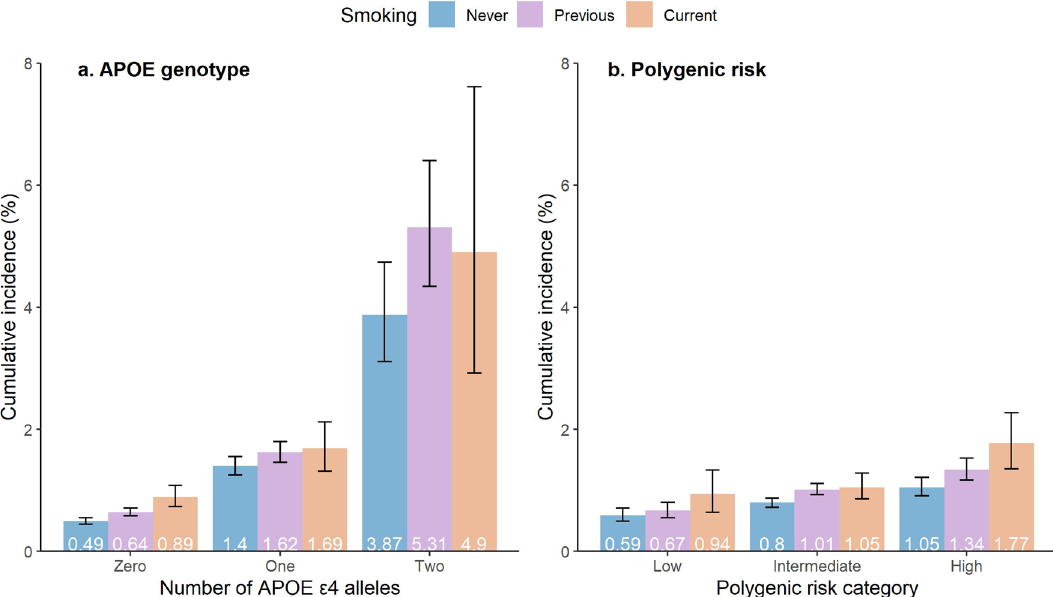
Figure 1. Cumulative incidence of dementia according to genetic predispostion and smoking status. Shown are cumulative incidence of dementia according to APOE genotype, polygenic risk category, and smoking status. The I bars represent 95% confidence